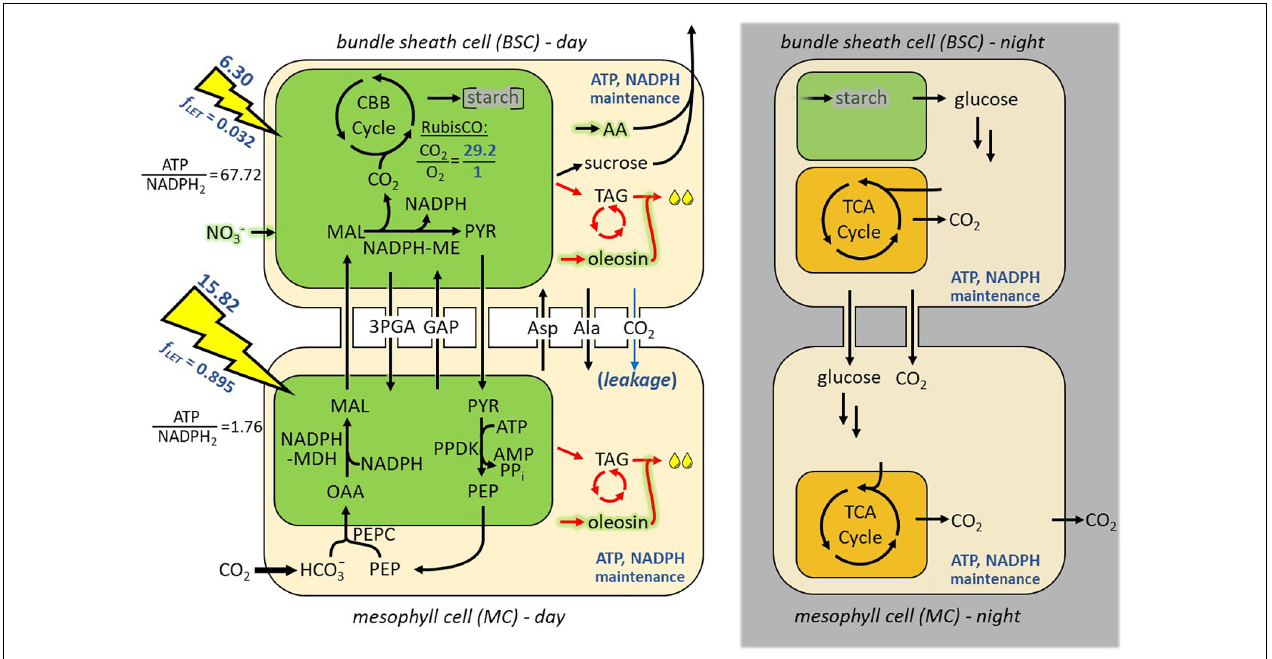
FIGURE 1 | Diel model of NADP-ME subtype C 4 photosynthesis in mesophyll and bundle sheath cells ( iTJC1414x4 ). Shown are the major metabolic processes in mesophyll (bottom row) and bundle sheath (top row) cells that are predicted to take place during photo-assimilation. Chloroplastic and mitochondrial compartments are shown in green and orange, respectively. Model constraints that pertain to the mature leaf reference state described in the text (i.e., distribution of photosynthetic energy, maintenance respiratory processes, RubisCO oxygenation, and CO 2 leakage) are indicated in blue (see also Supplementary Table 2 ). For both cell types, fixed proportions of ATP and NADPH supply by light reactions are indicated (see main text). Carbon reallocation to TAG and lipid futile cycle pathways is are indicated in red (see main text). Diel cycling was simulated with light being only accessible for the day sub-models (left column), which provides starch for use by the night sub-models (right column). On the night side of the model catabolic and respiratory activity is caused by fixed ATP and NADPH maintenance costs. Nitrate assimilation is indicated in green shading. 3PGA, 3-phosphoglycerate; AA, amino acids; AcCoA, acetyl coenzyme A; Ala, alanine; Asp, aspartate; CBB cycle, Calvin–Benson–Bassham cycle; f LET , fraction of absorbed light that drives linear electron transport; GAP, D-glyceraldehyde 3-phosphate; MAL, malate; ME, malic enzyme; MDH, malate dehydrogenase; NO 3 − , nitrate; OAA, oxaloacetate; PEP, phosphoenolpyruvate; PEPC, phosphoenolpyruvate carboxylase; PPDK, pyruvate phosphate dikinase; PYR, pyruvate; RubisCO, ribulose 1,5-bis-phosphate carboxylase/oxygenase; TAG, triacylglycerol; TCA, tricarboxylic